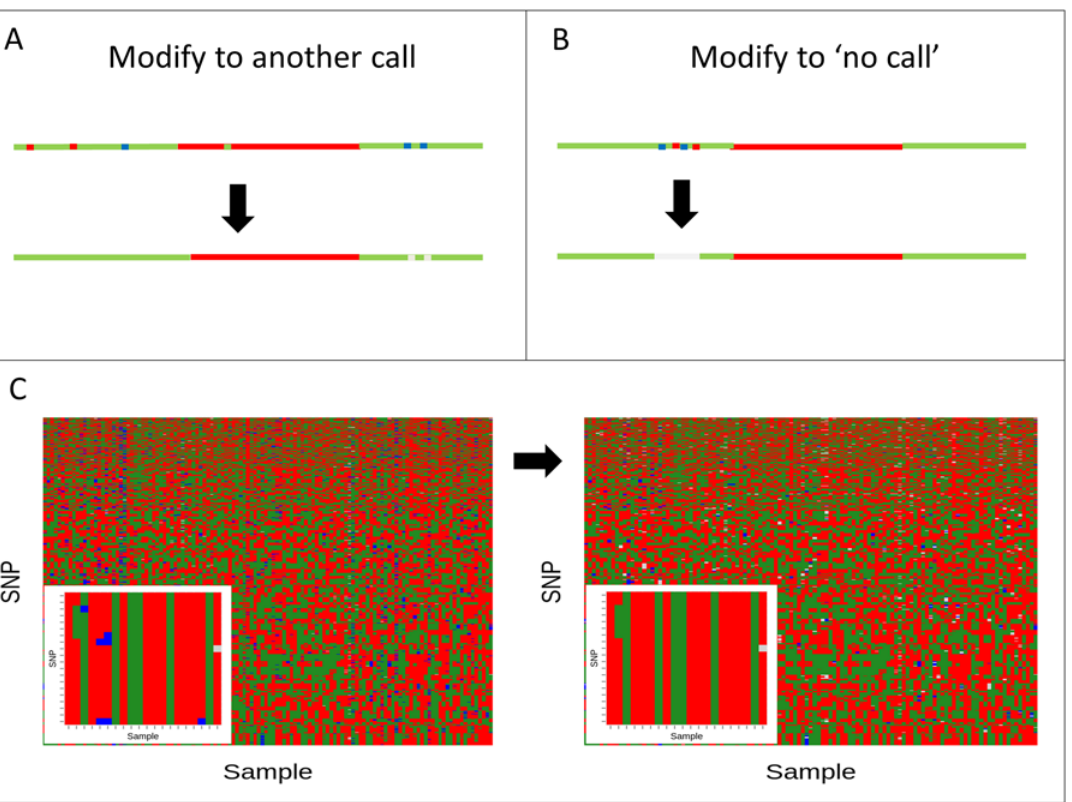
Fig 2. Illustration of genotype call refinement. Genotype call refinement was performed to improve the genotype call for stretches or blocks. Inconsistencies within a block were corrected to either the genotype block (AA — red; BB — green; AB — blue) or to no call (light gray). (A) An example of specific locus refinement by flanking loci according to the following criteria. First, six or more flanking loci from both sides of the locus were called other than the locus call, but consecutively. This locus was modified to the call of the flanking loci. Otherwise, if the flanking loci did not contain uniformly consecutive calls, the locus call was set to ‘ no call ’ . (B) If a region was stretched out over 12 or more different consecutive calls, the whole region was set to ‘ no call ’ . (C) A heatmap plot of the genotype calls, before and after refinement. To illuminate the improvement, a zoom into a subset of SNPs and RILs of 20 x 20 (left bottom corner) was plotted.